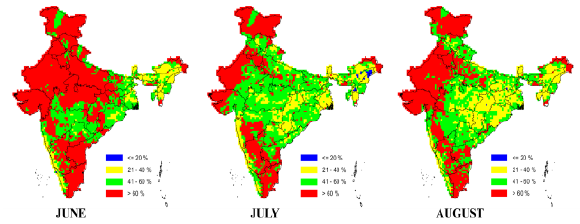
Figure 6: CV of rainfall in June, July and August months. series)